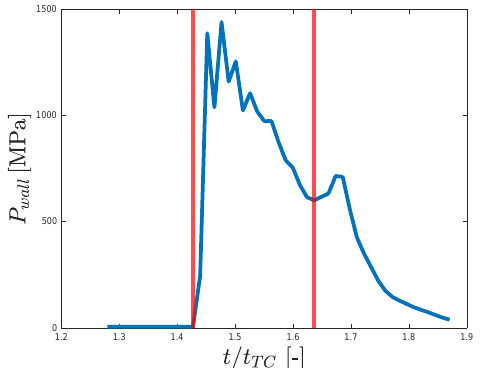
Figure 3. Pressure trend over the green region of Figure 1 for a non-symmetrical wall attached collapse ( dL / R 0 =133, γ = 0.6 & P ∞ = 50 [MPa]). The profile is divided in three regions: ( I ) Jet formation, ( II ) Jet impact and ring formation, ( III ) Ring